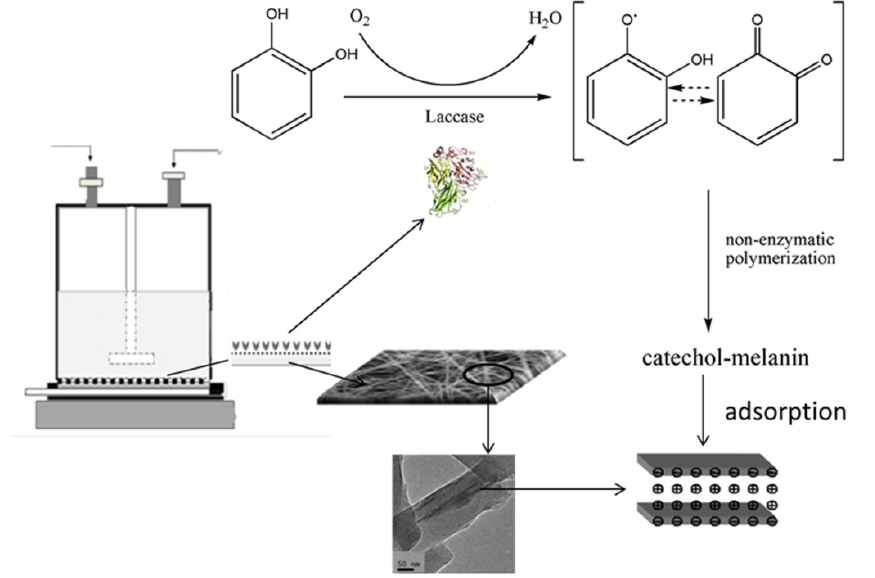
Figure 9. Schematic illustration of the homemade membrane reactor for catechol